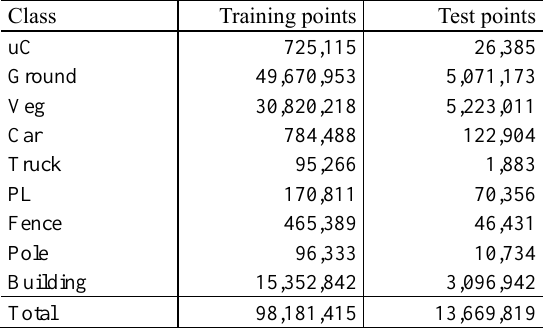
Table 3. Points distribution for the training and test